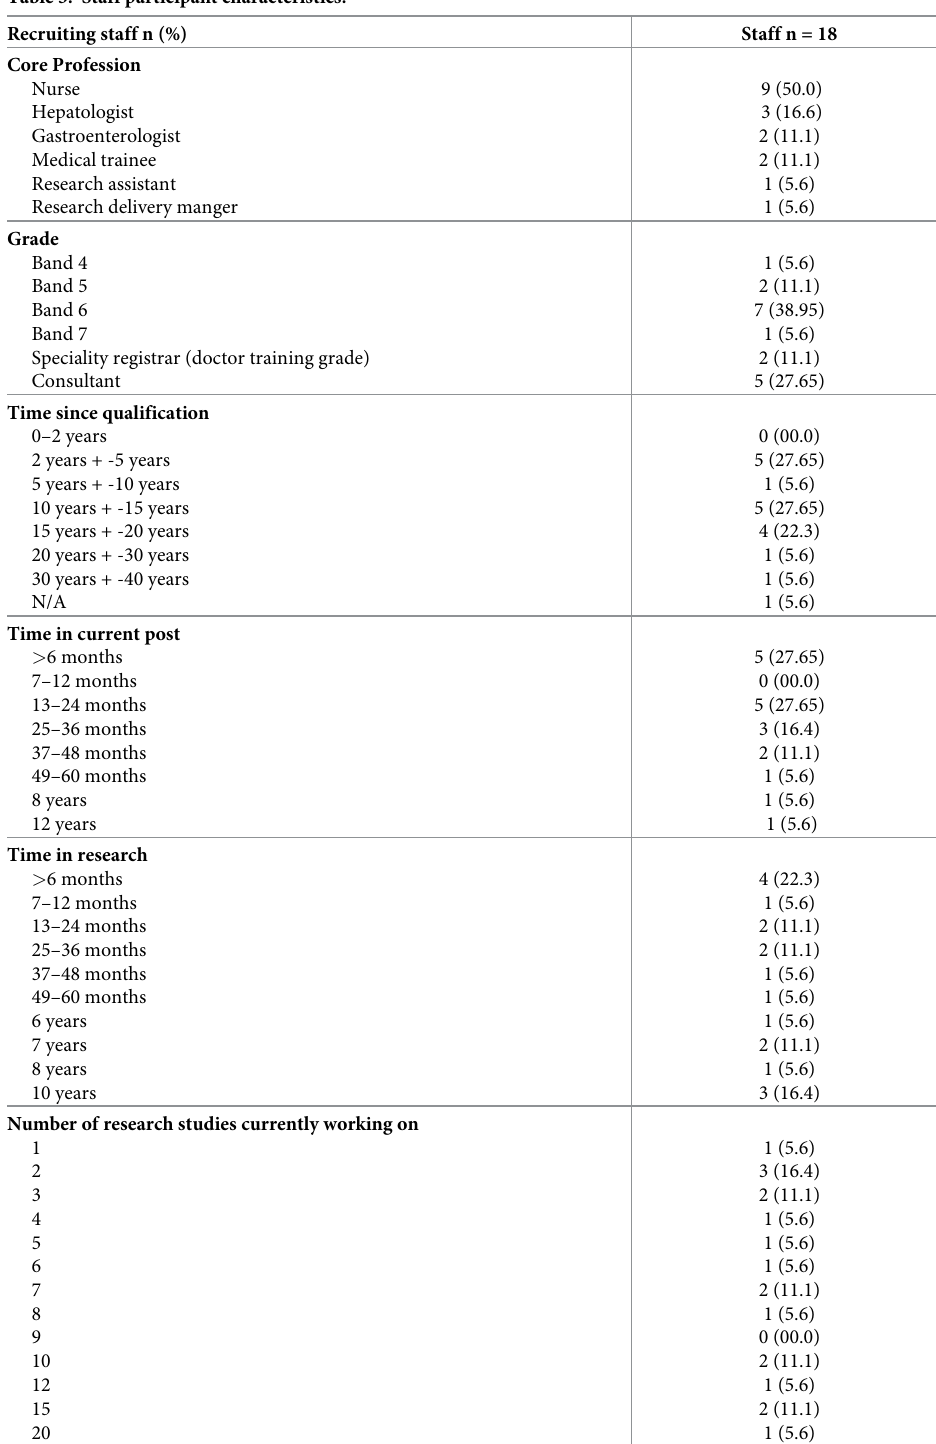
Table 3. Staff participant